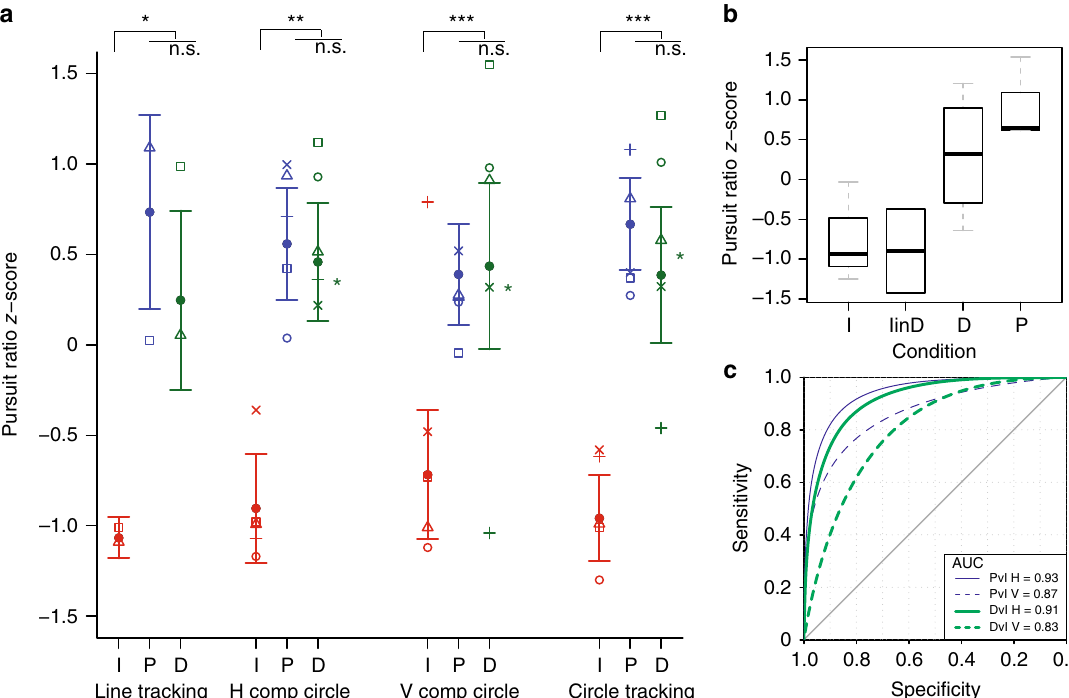
Fig. 3 Pursuit ratio scores for perception, dreaming and imagination tracking. a Median values of normalized pursuit ratio scores in horizontal line tracking (Line tracking), horizontal (H comp circle), vertical (V Comp Circle) and joint (Circle tracking) components of circle tracking during imagination (I, red line and symbols), perception (P, blue line and symbols) and dreaming (D, green line and symbols). Symbols designate medians for individual subjects. Green stars to the right of D indicate pursuit ratio z -score values for the non-lucid REM sleep dream tracking trial. Given that the data were not normally distributed and contained varied numbers of repeated observations within subjects, data were analyzed using a linear mixed model and nonparametric bootstrapping (two-sided, paired test) was used to compare P (circle tracking: N = 5, trials = 28; line tracking: N = 2, trials = 3), D (circle tracking: N = 5, trials = 21; line tracking: N = 3, trials = 5) and I (circle tracking: N = 5, trials = 28; line tracking: N = 2, trials = 3) conditions (replications = 1), *P < 0.001, *P < 0.0001, ***P < 0.00001. Error bars show s.e.m. b Boxplot showing pursuit ratio z -scores during horizontal line tracking task for imagination (I), imagination in the dream (I in D), perception (P) and dreaming (D) conditions. The bottoms and tops of the boxes show the 25th and 75th percentiles (the lower and upper quartiles), respectively; the inner band shows the median; and the whiskers show the upper and lower quartiles ± 1.5 × the interquartile range (IQR). c Area under the ROC curve (AUC) for perception versus imagination (PvI) H (horizontal EOG) (thin blue solid line) and V (vertical EOG) (thin blue dotted line) and dreaming versus imagination (DvI) H (thick green solid line) and V (thick green dotted line) components of eye